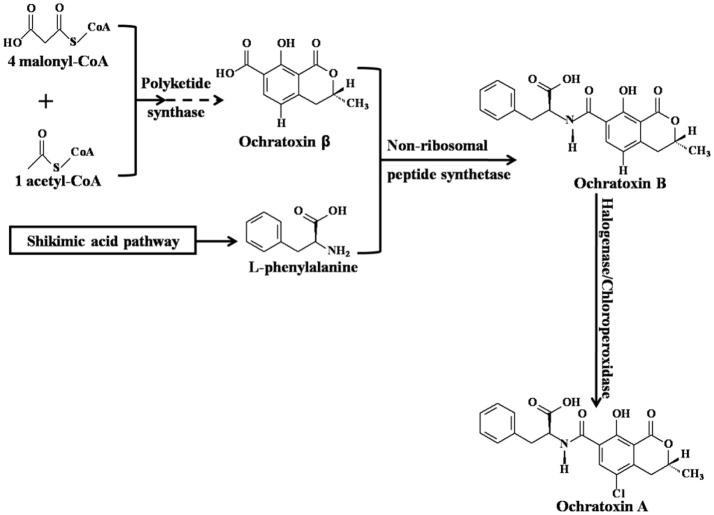
Critical steps of Ochratoxin A biosynthesis [adapted from (Gallo et al., 2017)].